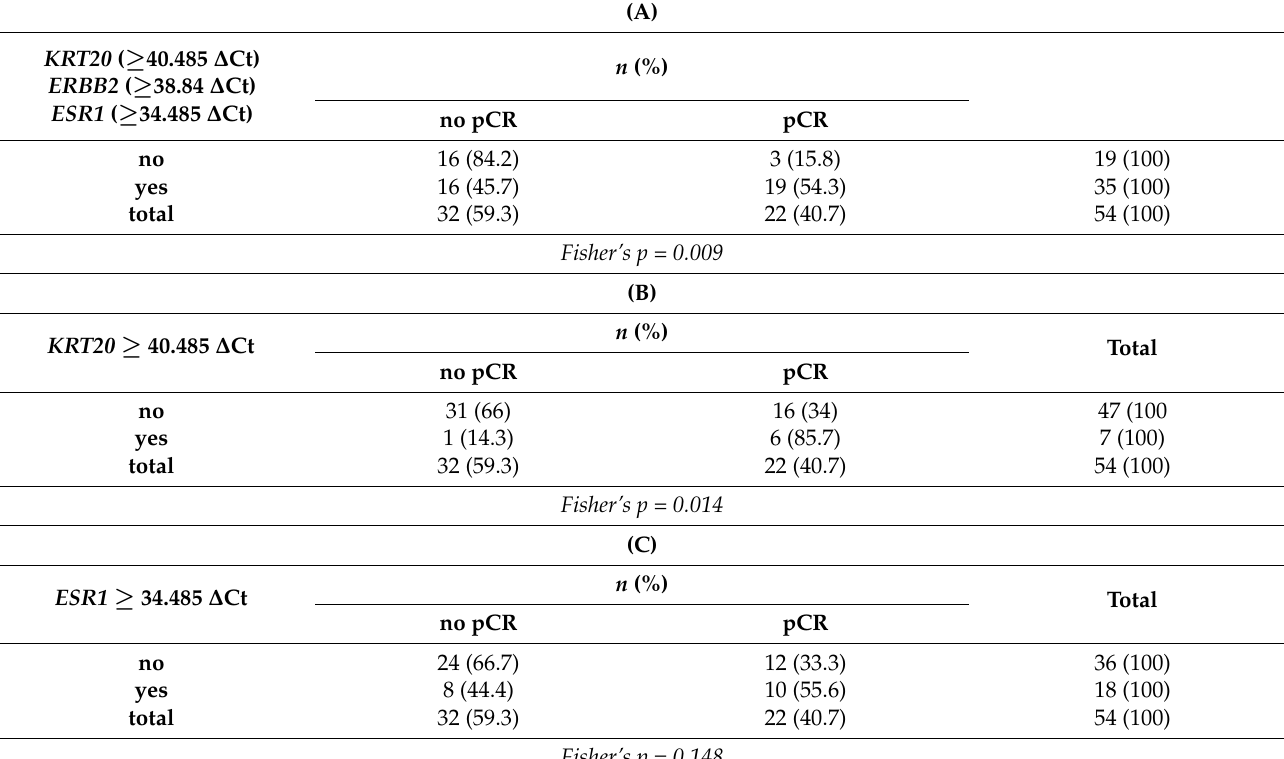
Table 3. Contingency tables of combined KRT20, ERBB2 and ESR1 (A), KRT20 (B) and ESR1 (C) cut-offs at transurethral resection before the start of neoadjuvant chemotherapy in relation to pathological complete response (pCR) at cystectomy. (A)